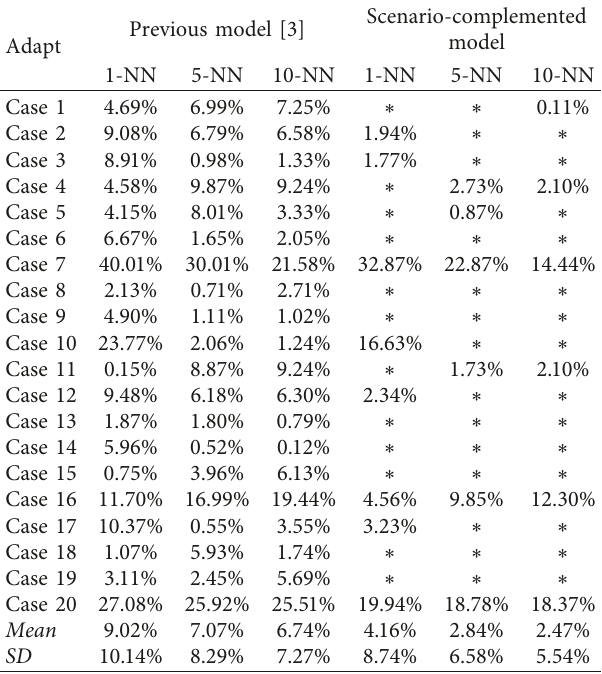
Table 9: Absolute error ratio (AER) comparison.